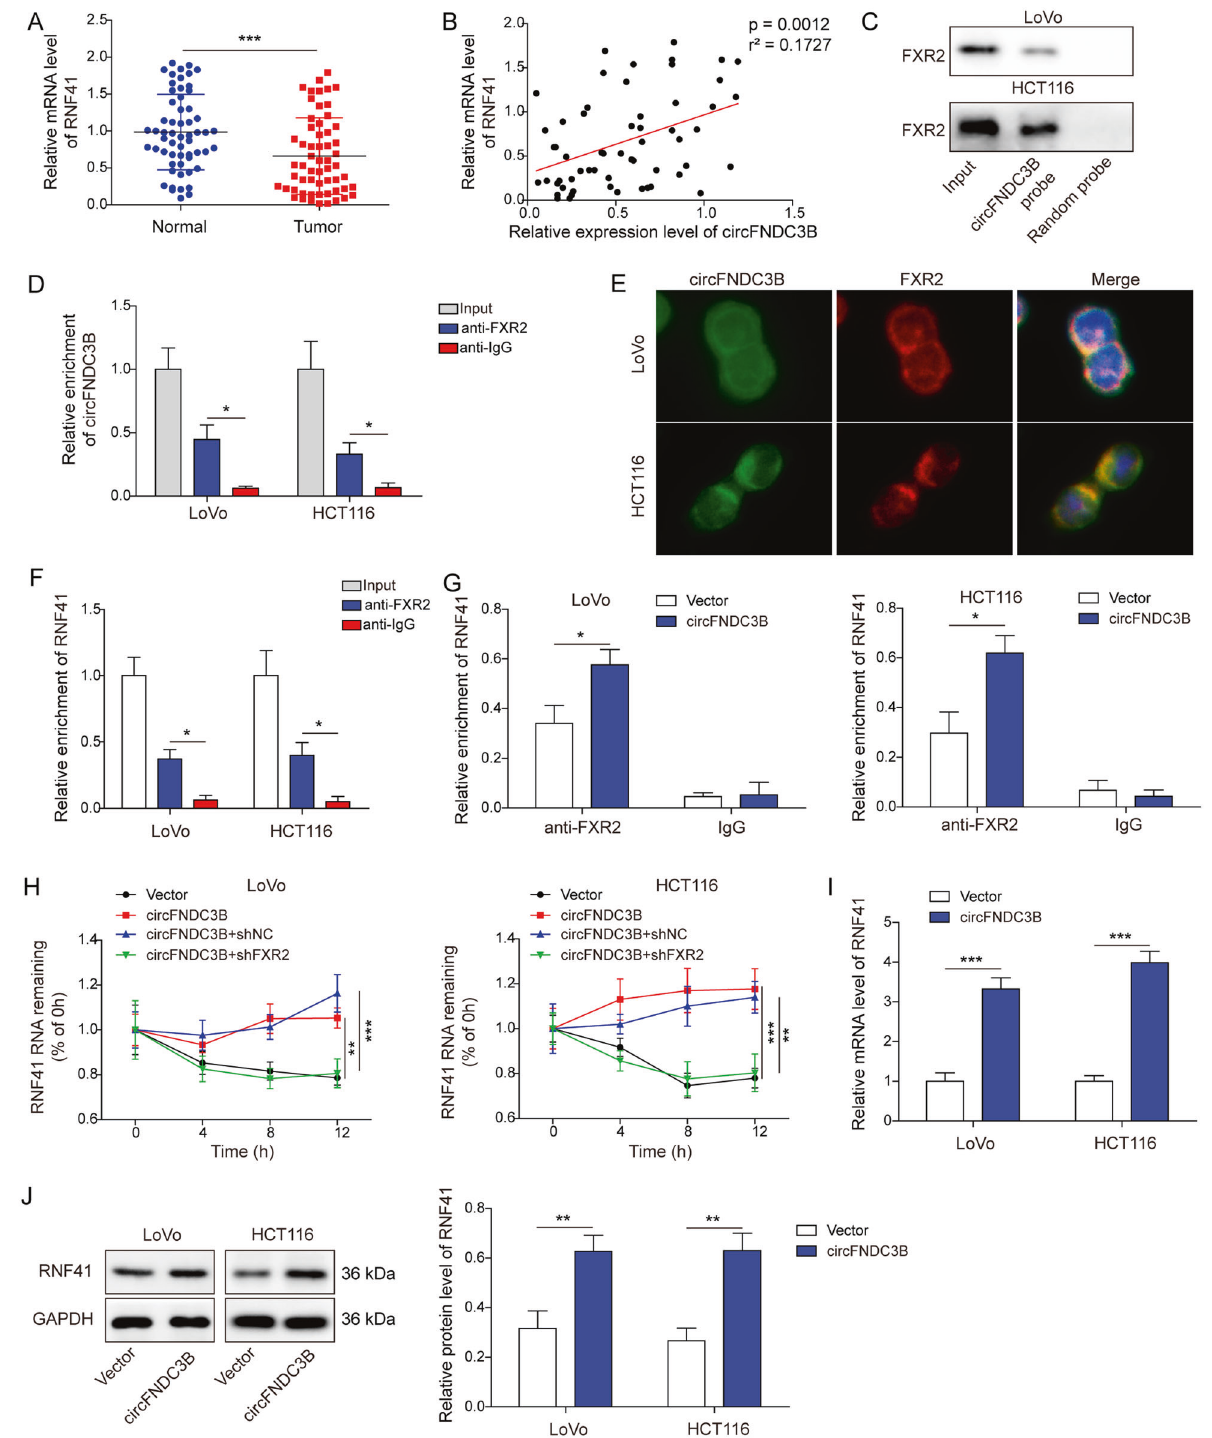
Fig. 4 circFNDC3B increases RNF41 mRNA stability and expression via binding to FXR2. A The RNF41 level in CRC tissues was detected by qRT-PCR. B The correlation between circFNDC3B and RNF41 level in CRC tissues was analyzed by spearman correlation analysis. C The interaction between biotinylated circFNDC3B and FXR2 was detected by RNA pull-down assay. Random probe acted as a negative control. D The interaction between circFNDC3B and FXR2 was detected by RIP assay. Normal IgG served as a negative control. E The co-localization of circFNDC3B and FXR2 was detected by RNA FISH and immuno fl uorescence (IF). Scale bar, 10 μ m; Green, circFNDC3B; Red, FXR2; Blue, DAPI. F , G The interaction between RNF41 and FXR2 was detected by RIP assay. Normal IgG served as a negative control. H The mRNA stability of RNF41 was determined by RNA stability assay. I , J The mRNA and protein levels of RNF41 in transfected CRC cells were detected by qRT-PCR and Western blotting. * P < 0.05, ** P < 0.01, *** P < 0.001.